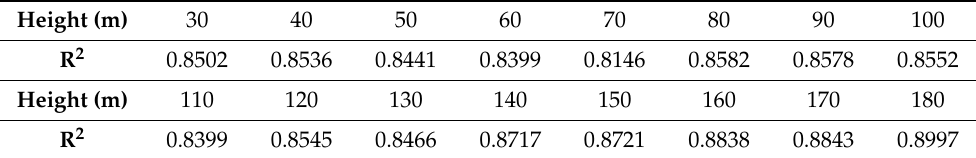
Table 8. Goodness-of-fit test of AL model.